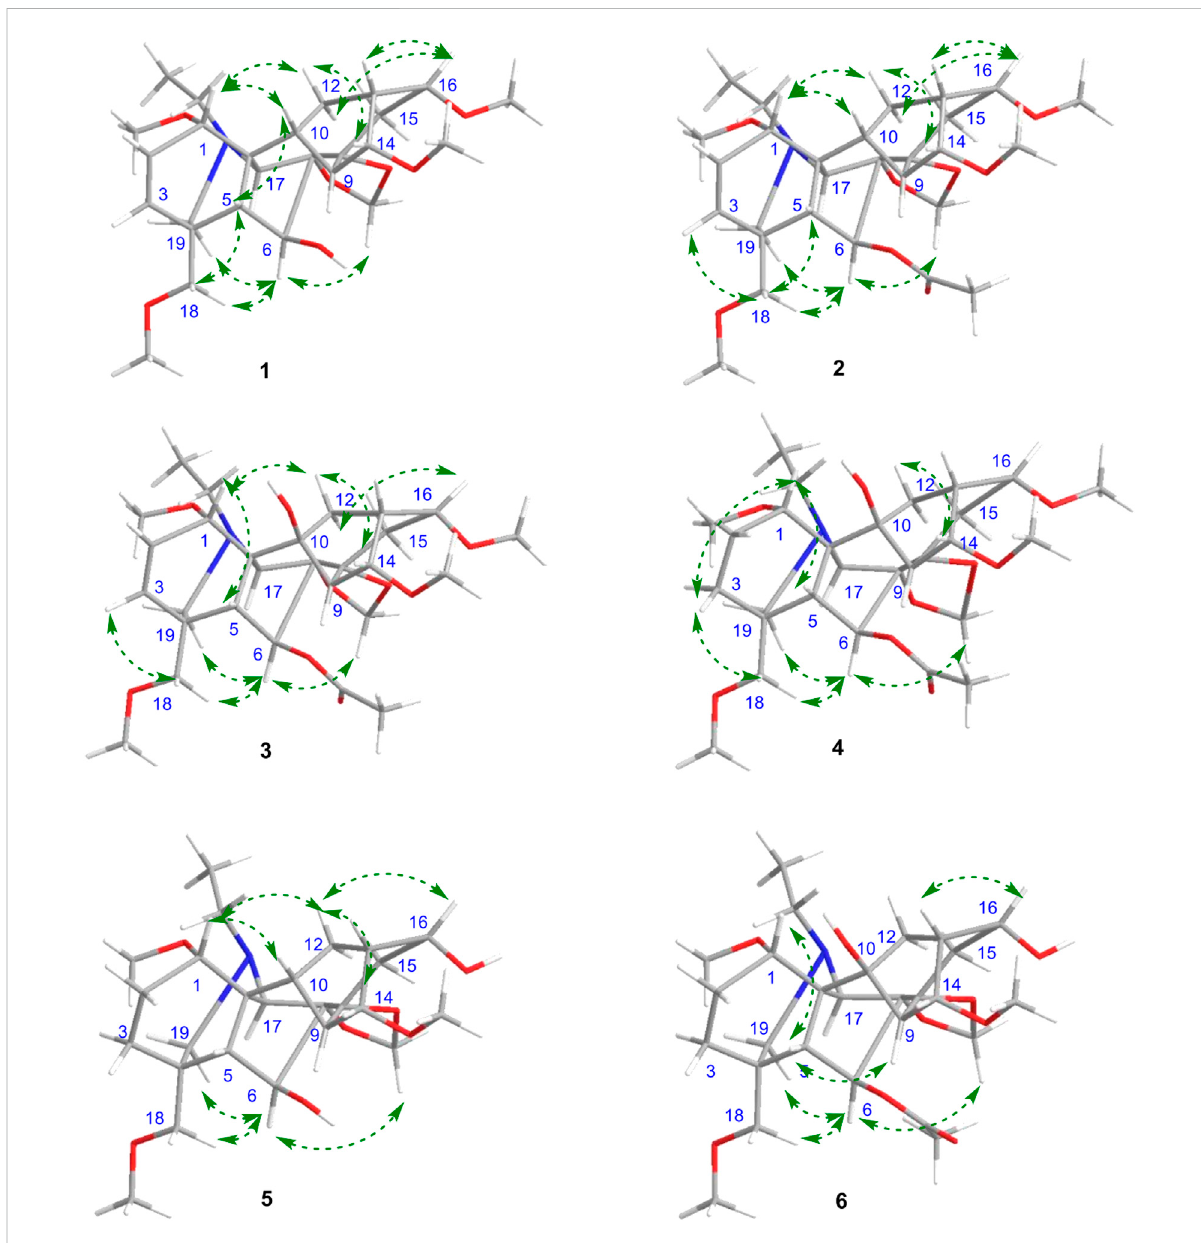
FIGURE 3 Key NOESY correlations of six new diterpenoid alkaloids.